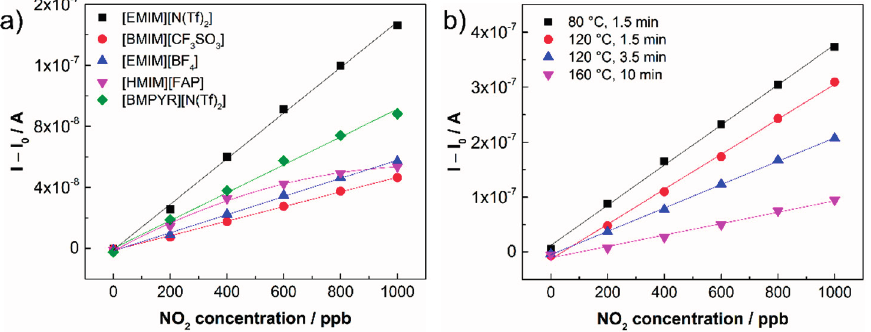
Figure 4. ( a ) Dependence of sensor current on NO 2 concentration for different ionic liquids in SPE; ( b ) Dependence of sensor current on NO 2 concentration for different thermal treatment conditions during the formation of the SPE layer with [EMIM][N(Tf) 2 ] ionic liquid: sample No. 1, 80 °C for 1.5 min; sample No. 2, 120 °C for 1.5 min; sample No. 3, 120 °C for 3.5 min and sample No. 4, 160 °C for 10